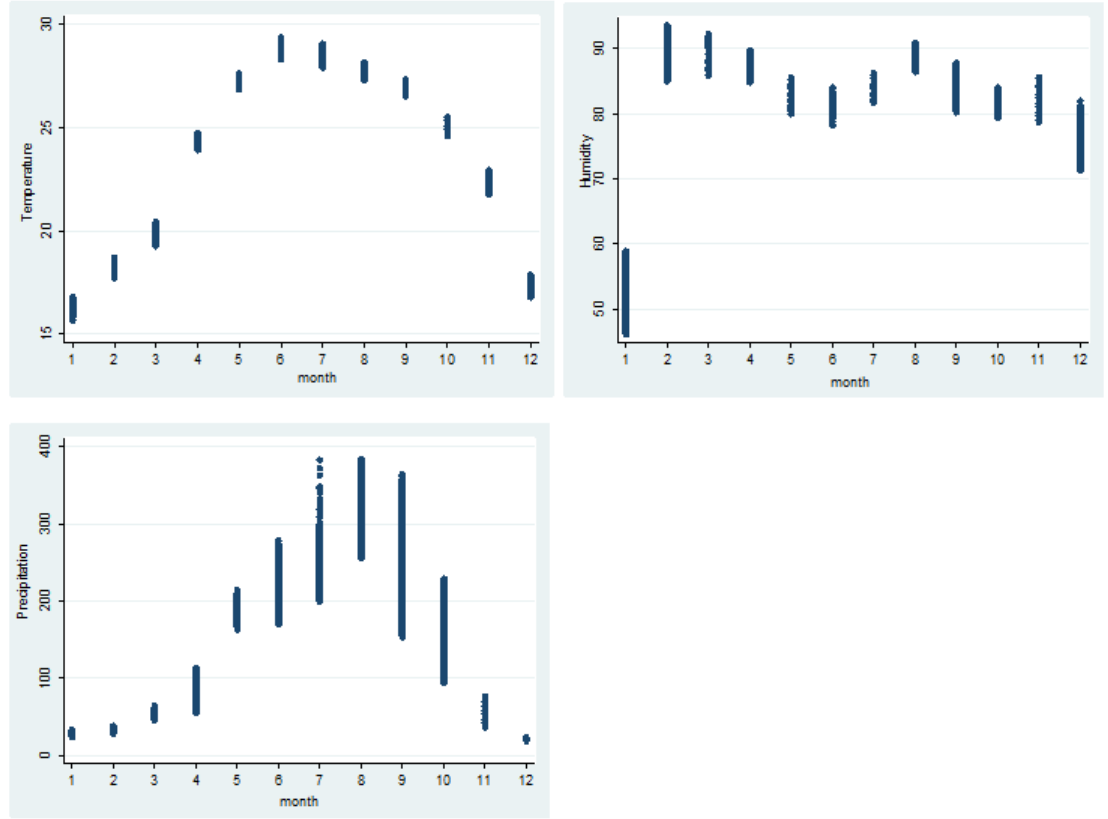
Figure 7. Weather patterns by months in the Red River Delta from 2003 to